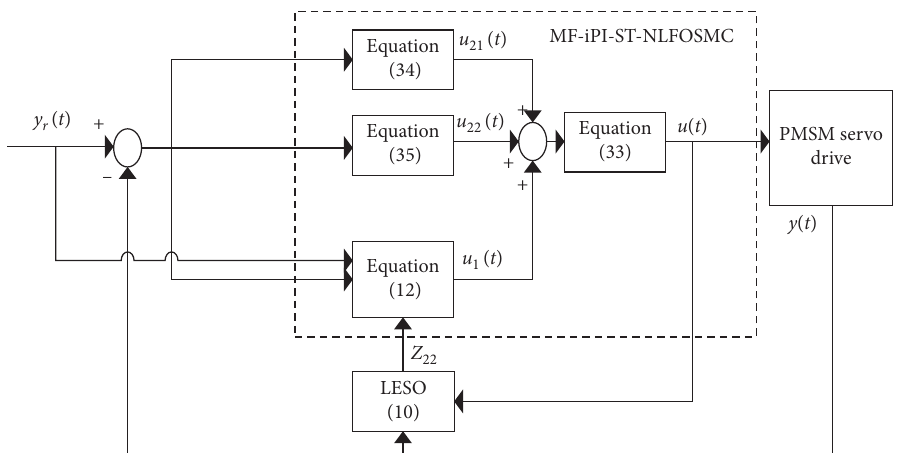
Figure 3: Structural diagram of the proposed MF-iPI-ST-NLFOSMC